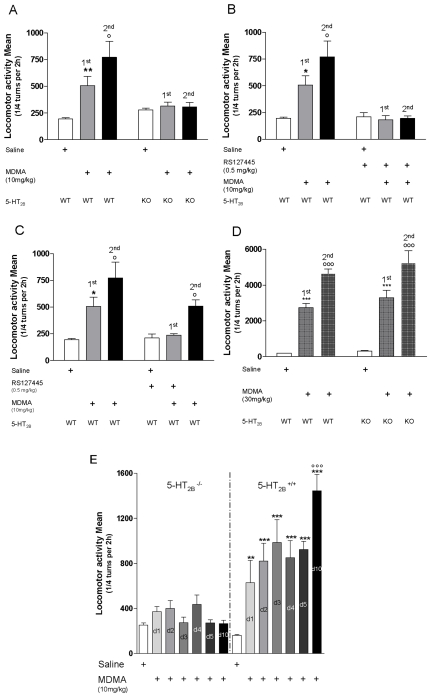
Effect of 5-HT2B receptor inhibition on locomotor activity and behavioral sensitization after MDMA injection.
Locomotor sensitization after MDMA two-injection protocol in WT and 5-HT2B−/− mice (A–D): MDMA (10 mg/kg i.p.) increases locomotor activity after the first injection (1st) in WT mice but not in 5-HT2B
−/− mice A) or RS127445-treated WT mice B). The stimulant effect of a challenge dose of MDMA (10 mg/kg) 7 days later (2nd) was significantly enhanced compared to the first injection in WT mice, while it had no effect in 5-HT2B
−/− mice A) or RS127445 pre-treated WT mice B). To evaluate the role of 5-HT2B receptors in the development of locomotor sensitization, WT mice were treated with RS127445 30 min before the first injection of MDMA. The increased responsiveness to the challenge injection of MDMA in absence of RS127445 was totally abolished C). MDMA (30 mg/kg i.p.) induces locomotor activity after the first injection in WT and 5-HT2B
−/− mice compared to saline injection D). The stimulant effect of a challenge dose of MDMA (30 mg/kg) was significantly enhanced compared to the first injection in both WT and 5-HT2B
−/− mice D). Data (means±SEM, n = 8−14 per group) were analyzed by two-way ANOVA with genotype (A–D) or RS127445 pre-treatment (B–C) and MDMA treatment as main factors. A significant interaction was observed for the locomotor activity in figure A) F (2,66) = 12.86 p<0.01, and B) F (2,54) = 11.49 p<0.01, as well as a main effect of genotype F (2, 66) = 15.68, p<0.001 (A) or RS127445 pre-treatment F (2, 54) = 10.24, p<0.05 (B) and of MDMA treatment F (1,66) = 9.26, p<0.001 (A), and F (1,54) = 17.04, p<0.001 (B). No significant interaction was observed for the locomotor activity in figure C) F (2,66) = 3.57, ns, whereas a main effect of RS127445 pre-treatment at the 1st MDMA injection, F (2,66) = 28.56, p<0.001, and of MDMA treatment F (1,66) = 6.64, p<0.01 were detected. Neither a significant interaction, F (2,50) = 0.25, ns, nor a main effect of genotype F (1,50) = 0.9, ns, was observed for the locomotor activity in figure D), whereas a main effect of MDMA treatment, F (2,50) = 82.72, p<0.001, was detected. Bonferroni tests were used for post-hoc comparisons. The null hypothesis was rejected at the p<0.05 level; *p<0.05; **p<0.01; ***p<0.001 compared to saline-treated mice. °p<0.05; °°°p<0.001 compared to MDMA 1st injection. Locomotor sensitization after repeated MDMA injection in WT and 5-HT2B−/− mice (E): MDMA (10 mg/kg i.p.) increases locomotor activity after the first injection (day 1; d1) in WT mice but not in 5-HT2B
−/− mice compare to saline injection. Repeated MDMA injection during the following days (Day 2 to 5, d2–d5) increases locomotor activity only in WT mice. The stimulant effect of a challenge dose of MDMA (10 mg/kg) 5 days later (day 10; d10) was significantly enhanced compared to the first injection in WT mice, while it had no effect in 5-HT2B
−/− mice. Data (means±SEM, n = 8 per group) were analyzed by two-way ANOVA with genotype and MDMA treatment as main factors. Bonferroni tests were used for post-hoc comparisons. The null hypothesis was rejected at the p<0.05 level; **p<0.01; ***p<0.001 compared to saline-treated mice. °°°p<0.001 compared to MDMA day 1 injection.